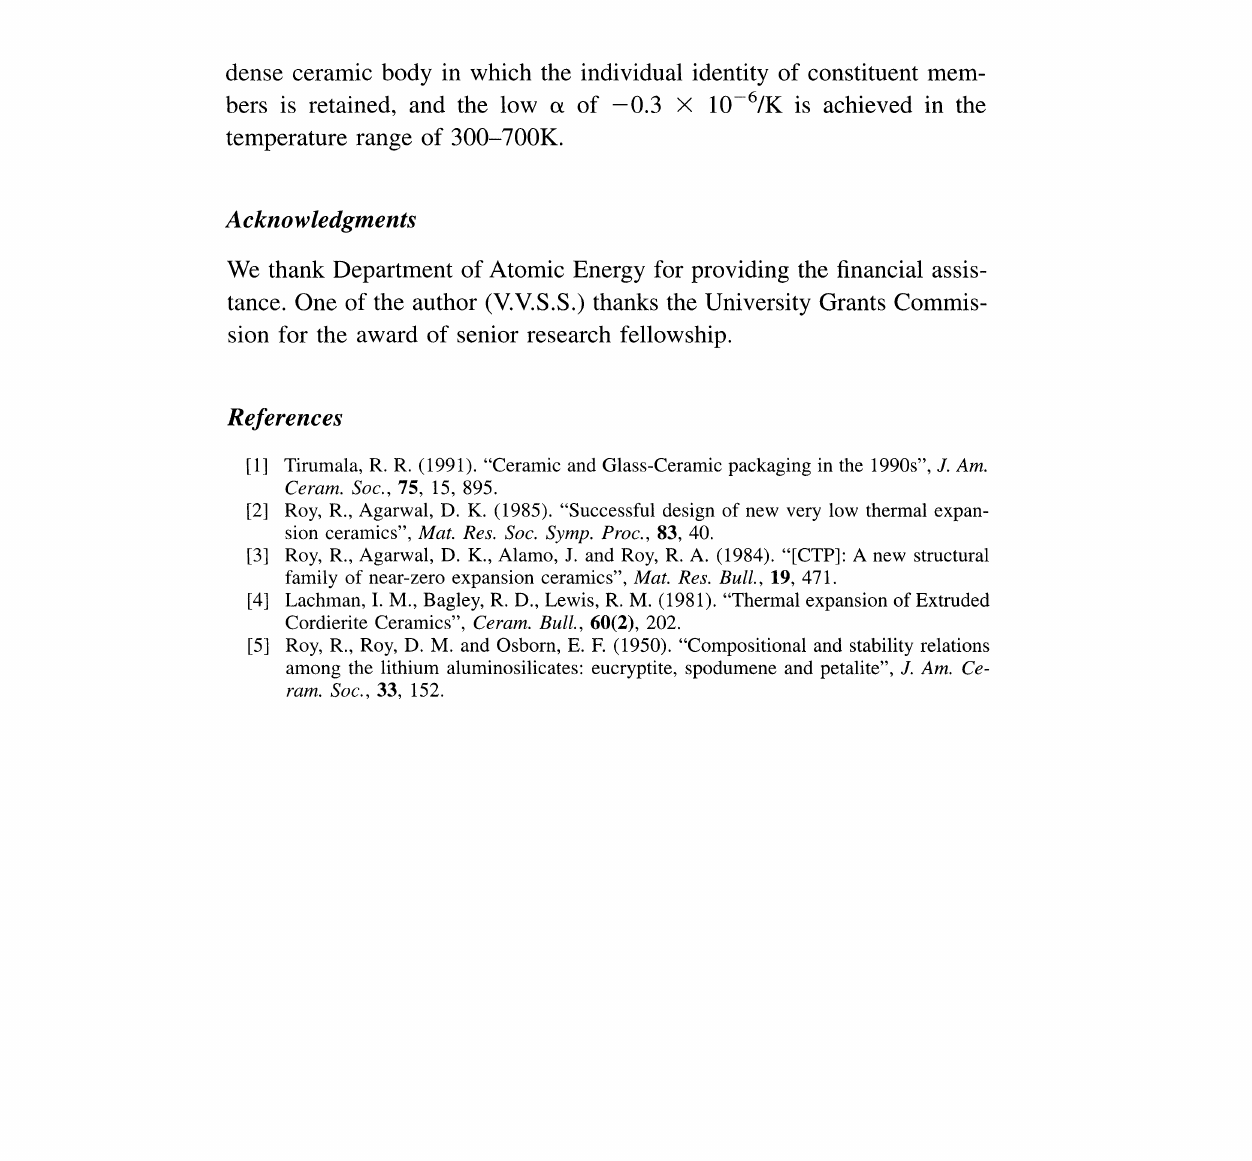
FIGURE 8 The variation of AL/L versus temperature for the composites PTo. + PFNo.5 (a,b) and PTo.65 + PFNo.3(c,d), heated at 1223K/15 min. and 1253K/60 min.